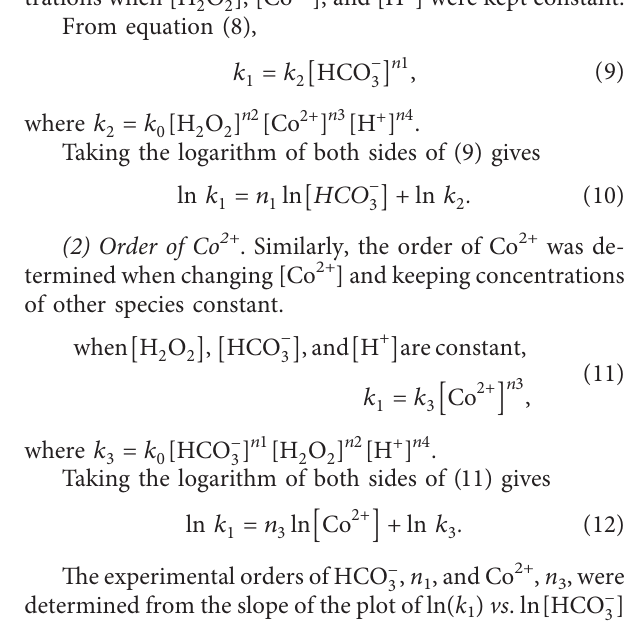
Figure 6: Dependence of (a) RB19 concentration and (b)ln ( Co / C Co 2+ , and pH